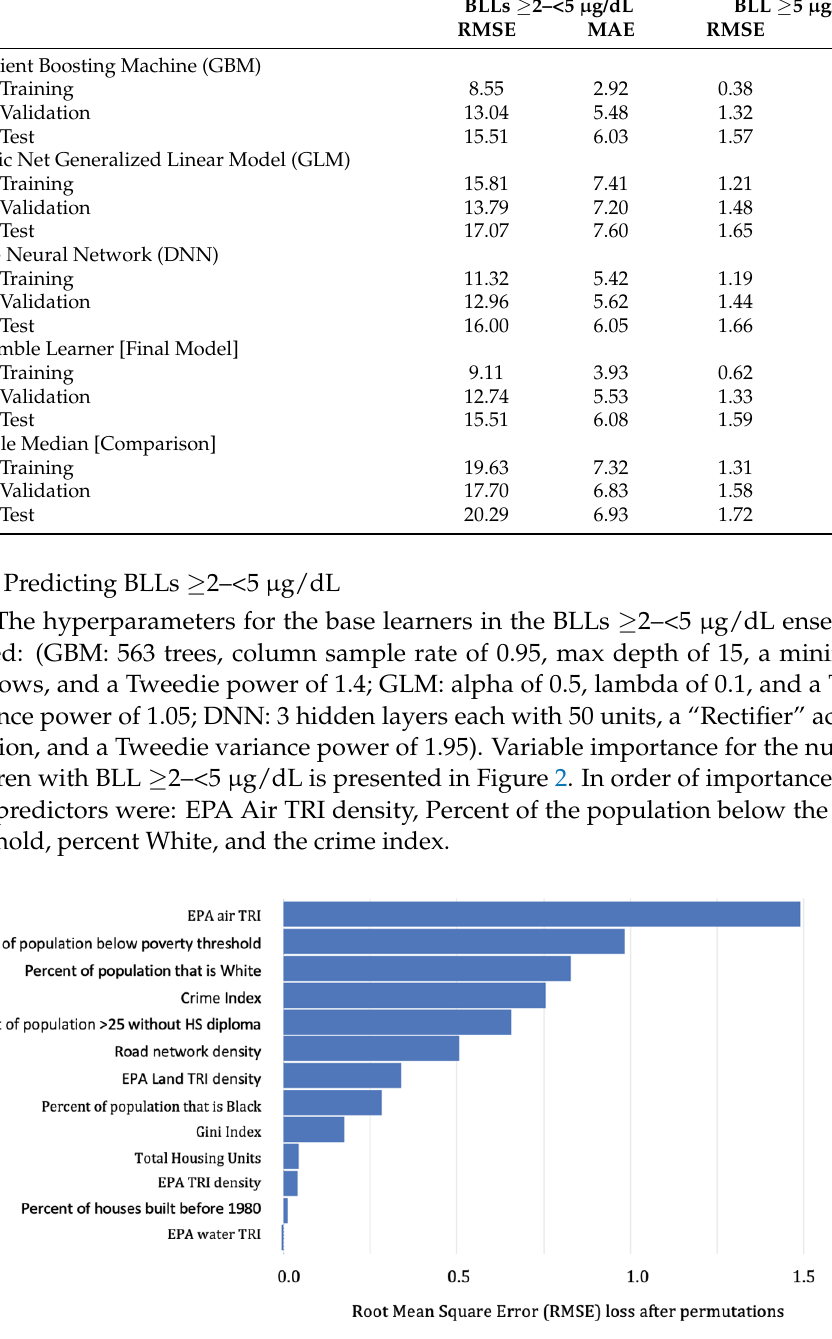
Figure 2. Predictor importance for ensemble learners predicting the number of children in a raster cell with BLLs ≥2– <5 µg/dL.